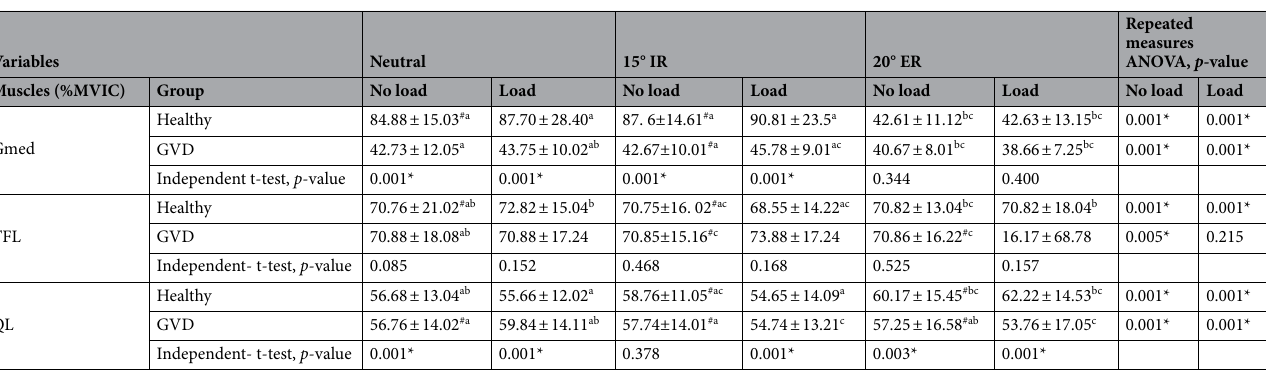
Table 2. Mean ± Standard deviation of normalized RMS EMG data for each muscle during the pelvic drop in different positions of hip rotation with and without load (isometric hip external rotation). IR Internal rotation of hip position, ER External rotation of hip position. * p ≤ 0/05: Bonferroni post hoc test: a a significant difference with 20 0 external rotations, b a significant difference with 15 0 internal rotation, c a significant difference with neutral. # a significant difference between pre-and post-load intervention based on the paired